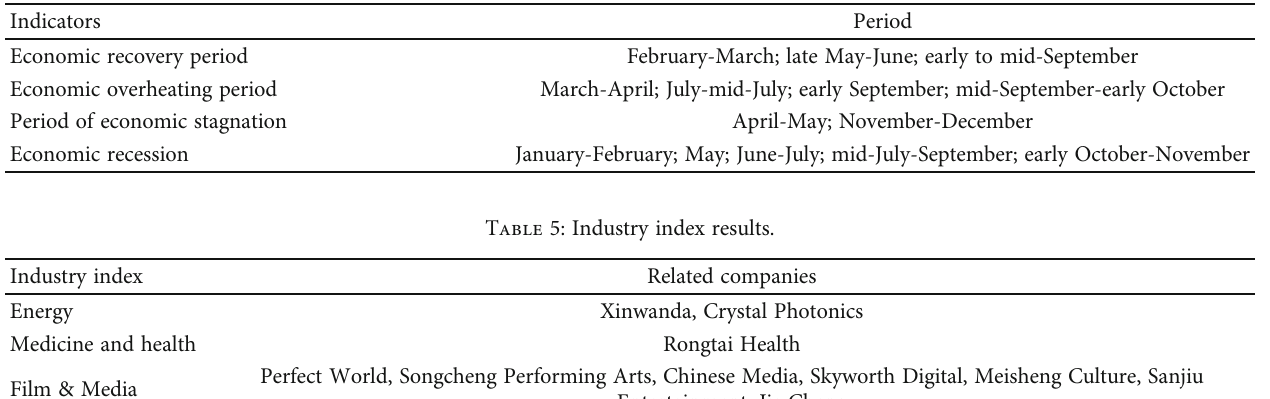
Table 4: Economic cycle segmentation results.